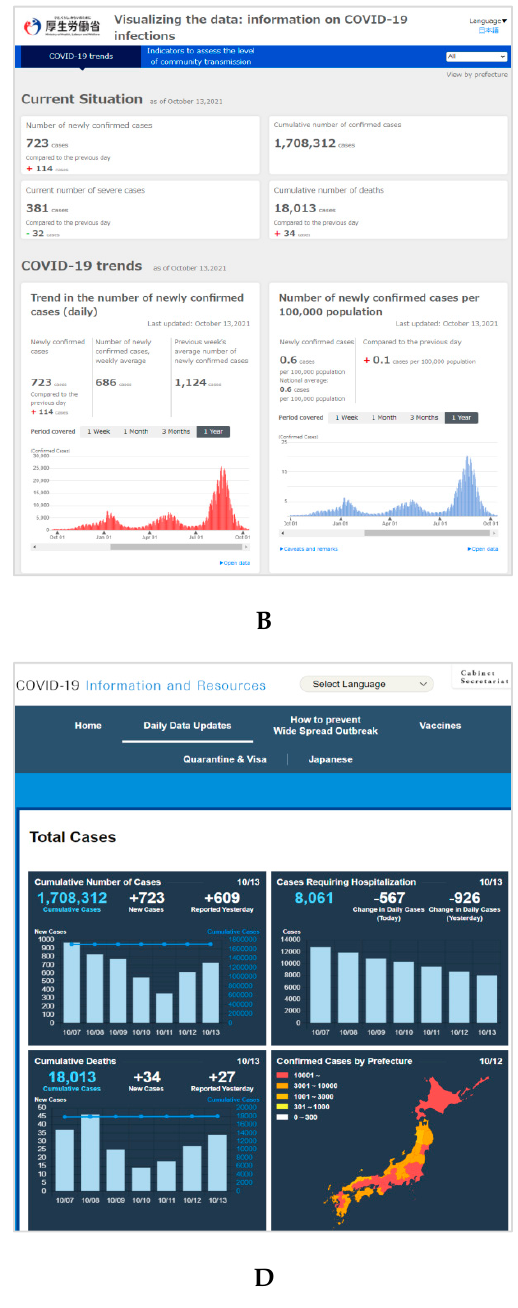
Figure 3. Homepages of the two dashboards in Japanese (left) and English (right) for Japan. ( A ) COVID-19 trends. Japan Ministry of Health Labor and Welfare. URL: https://covid19.mhlw.go.jp/extensions/public/index.html (In Japanese, accessed on